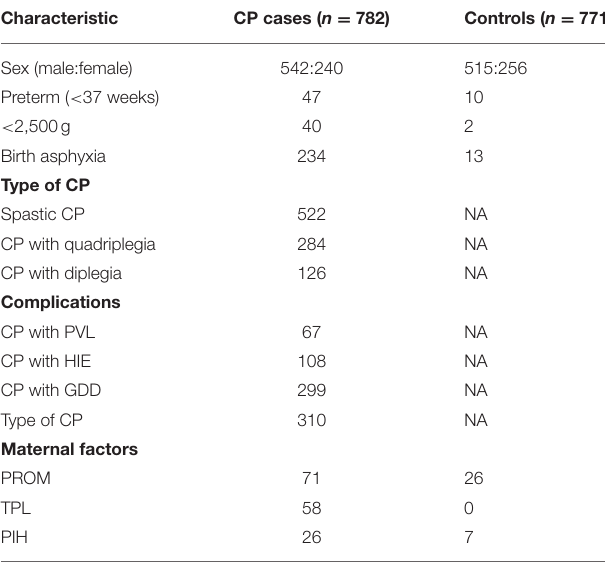
TABLE 1 | Clinical characteristics of all